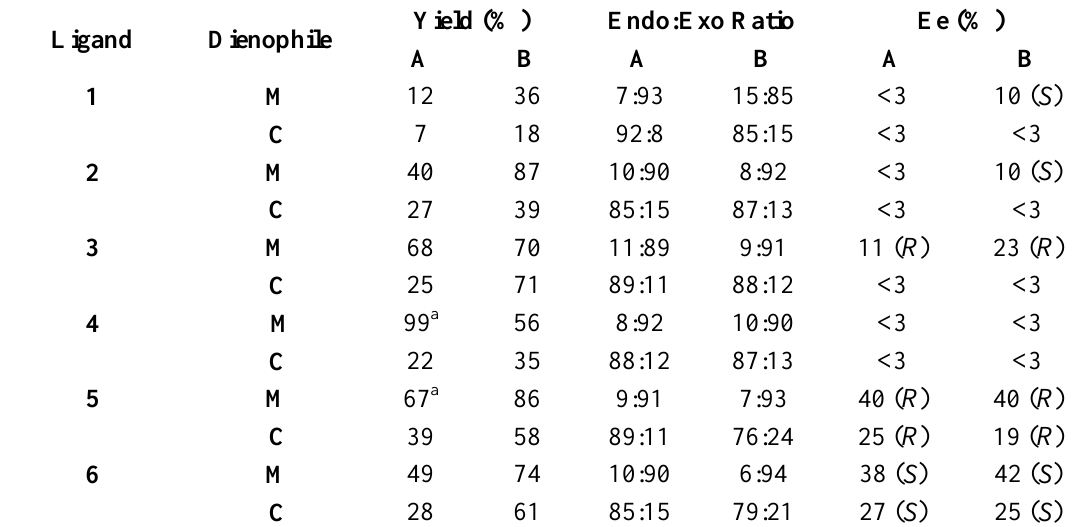
Table 1. Results of the Diels-Alder reaction using niobium(V) chloride. Yield